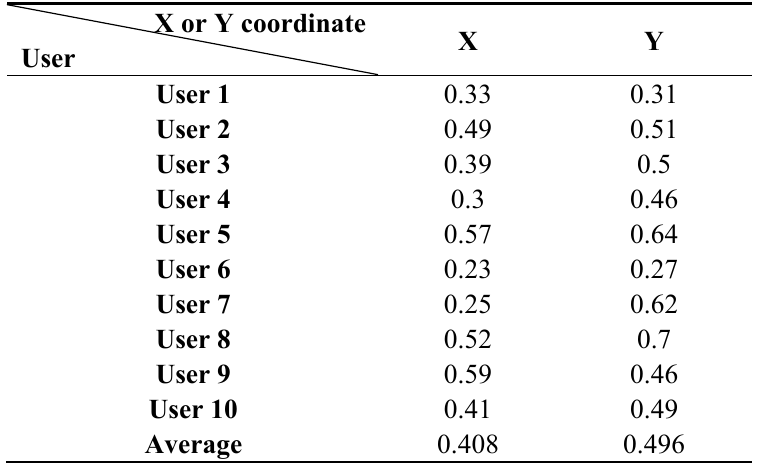
Table 7. The errors of gaze detection along X and Y-coordinates in cases where the users were not wearing glasses (units: